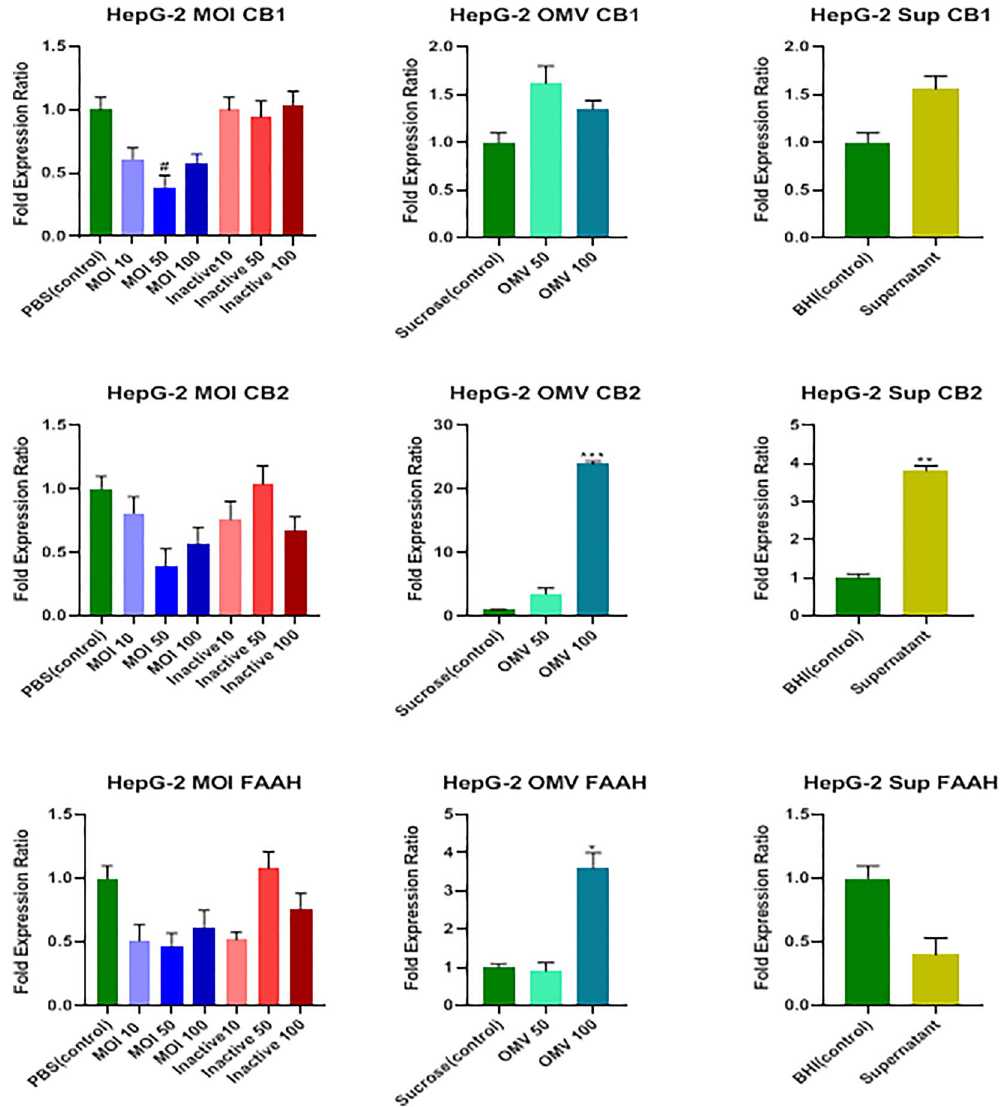
Figure 4. Effects of active and inactive A.muciniphila (at MOIs of 10, 50, and 100), its derived OMVs (50 and 100 μg/mL), and 7% (v/v [medium/cell-free supernatant]) cell free supernatant on the expression of endocannabinoid system related genes (CB1, CB2 receptors, and FAAH) in HepG-2 cells. Significancy is evaluated in comparison with control. Data are shown as the mean ± SEM. (*) and ( # ) represent significant increase and decrease, respectively.* P < 0.05, ** P < 0.01, *** P < 0.001 by one-way ANOVA and t-test statistical analysis. MOI: multiplicity of infection, OMV: outer membrane vesicle, Sup: